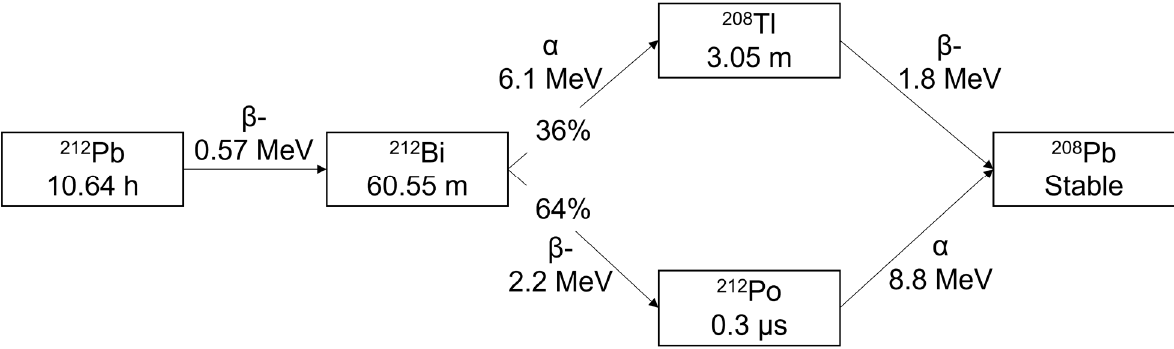
Figure 1. 212 Pb decay scheme [21,22].